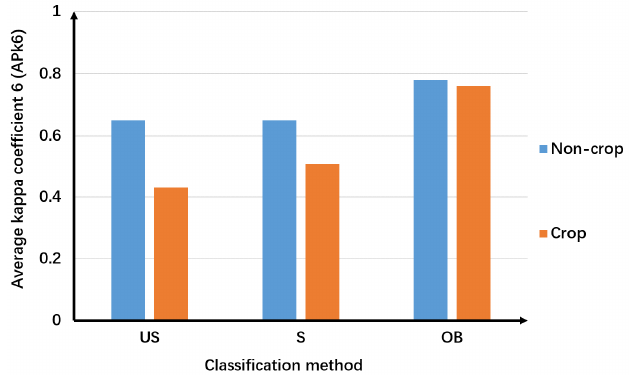
Figure 9. Average kappa coefficient difference for crop and non-crop by three classification methods (APk6) and difference of them. Unsupervised classification method (US), supervised classification method (S), object-based classification method (OB).